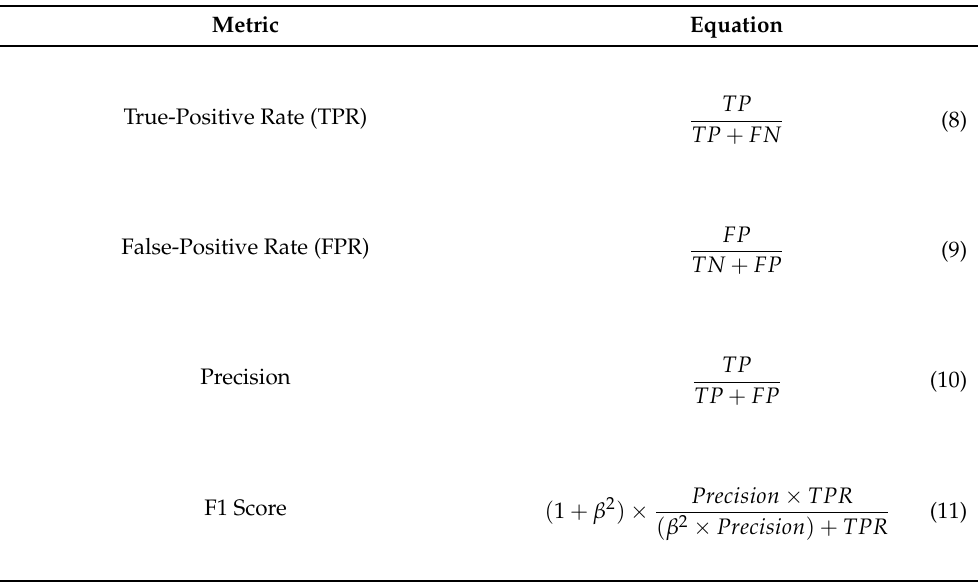
Table 5. The employed performance evaluation metrics. TP, TN, FP, and FN represent the true- positive, true-negative, false-positive, and false-negative values,